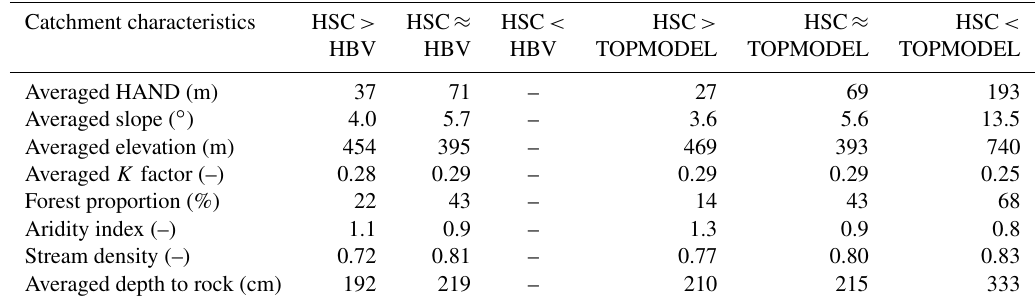
Forest proportion